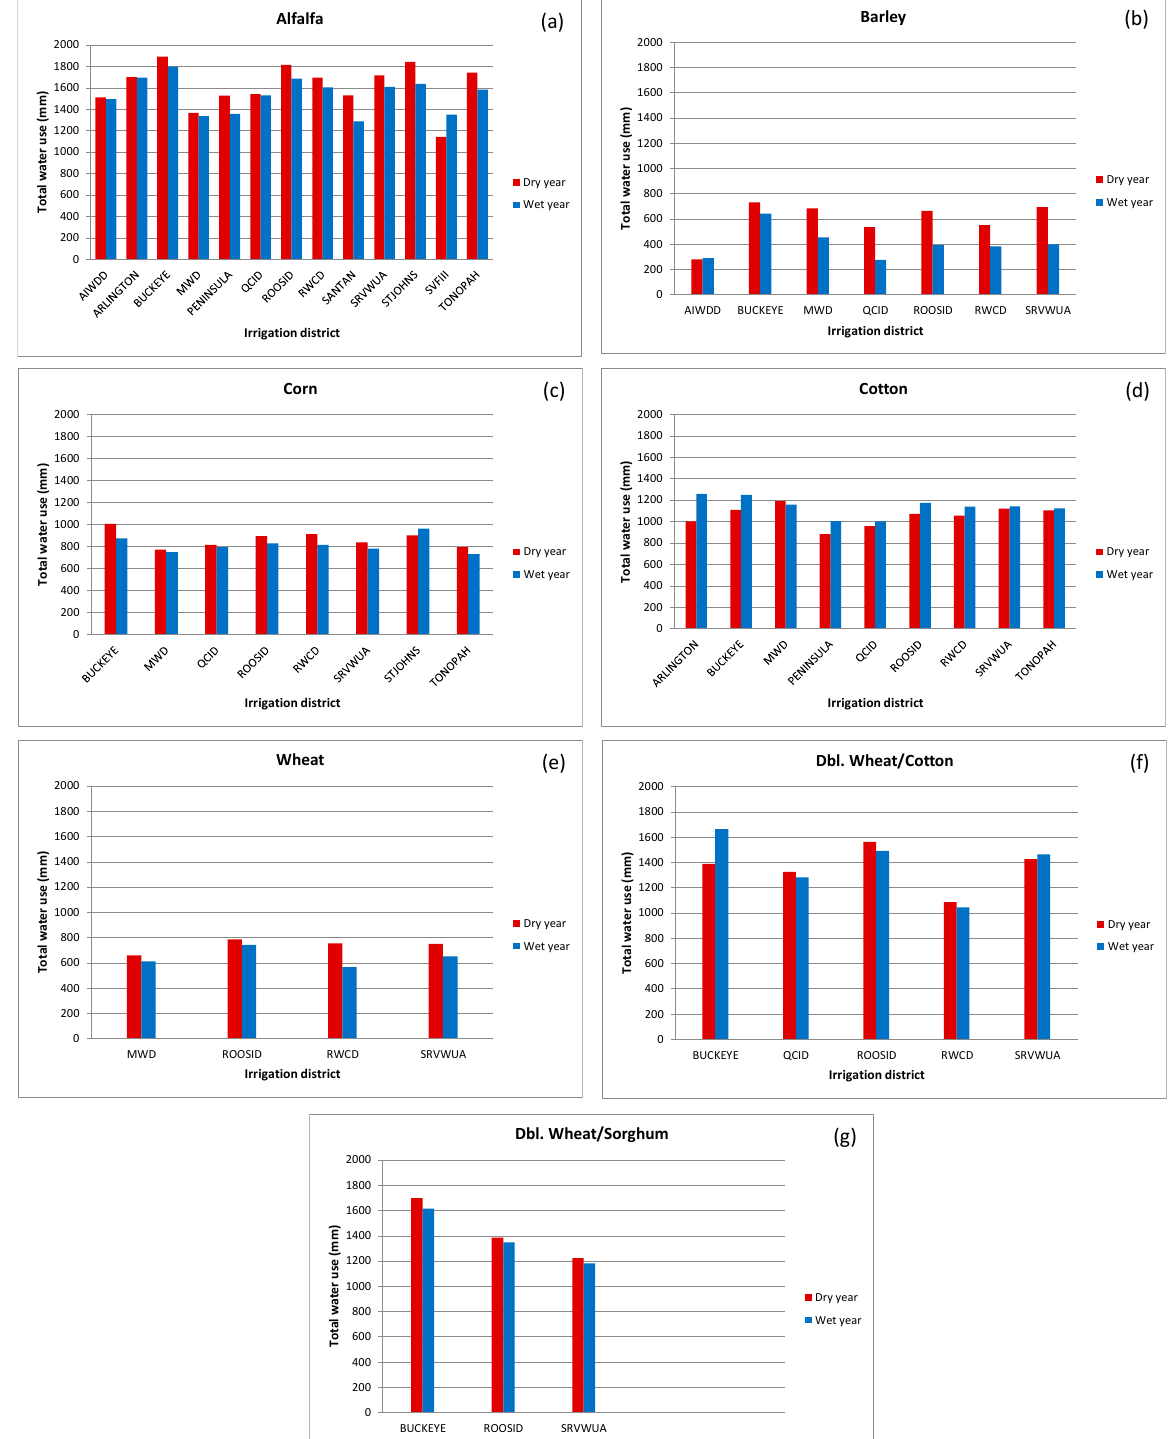
Figure 8. Water consumed by different crops across irrigation districts. ( a ) SVFIII water consumed for alfalfa was higher in a wet year than a dry year (an exception to the rest); ( b ) AIWDD water consumed for Barley was higher in a wet year than a dry year (an exception to the rest); ( c ) St. Johns water consumed for corn was higher in a wet year than a dry year (an exception to the rest); ( d ). MWD water consumed for cotton was higher in a dry year than wet year (an exception to the rest); ( e ) Water consumed for wheat was higher in dry year than wet year for all districts (i.e., SRVWUA, ROOSID, RWCD, MWD); ( f ) Water consumed for Dbl. Wheat/Cotton was higher in dry year than wet year for QCID, ROOSID, and RWD (an exception to the rest); ( g ) Water consumed for Dbl. Wheat/Sorghum was higher in dry year thanwet year for all districts (i.e., BUCKEYE, ROOSID,